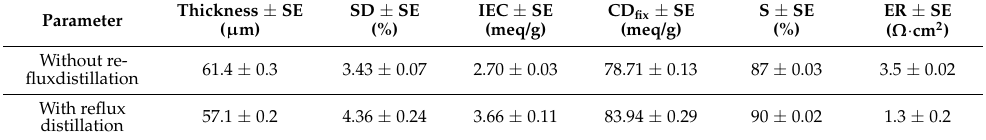
Table 8. Influence of the polymeric mixture pre-treatment on the membrane properties. Parameter